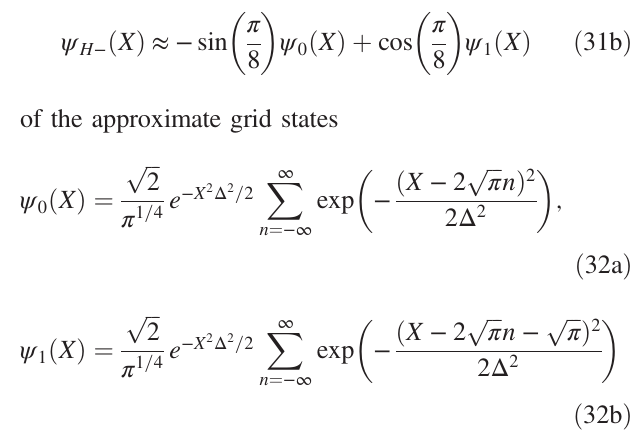
FIG. 7. Approximate GKP code words. We show with solid V 0 ¼ lines the linear combinations of the numerically obtained lowest- c X Þ of Eq. (30) that resemble the energy eigenfunctions ψ H (cid:4) ð X Þ ; see Eq. (31). The dashed light approximate GKP states ψ 0 ; 1 ð and dark gray lines show the analytical results in Eq. (32), respectively. The figure is obtained by using the same parameters V 0 ¼ 0 . 05 , which corresponds to as in Fig. 6, i.e., ℏ ω 2 0 = ω c Δ ¼ 0 . 25 . The widths of the individual peaks and that of the total envelope are the inverse of each